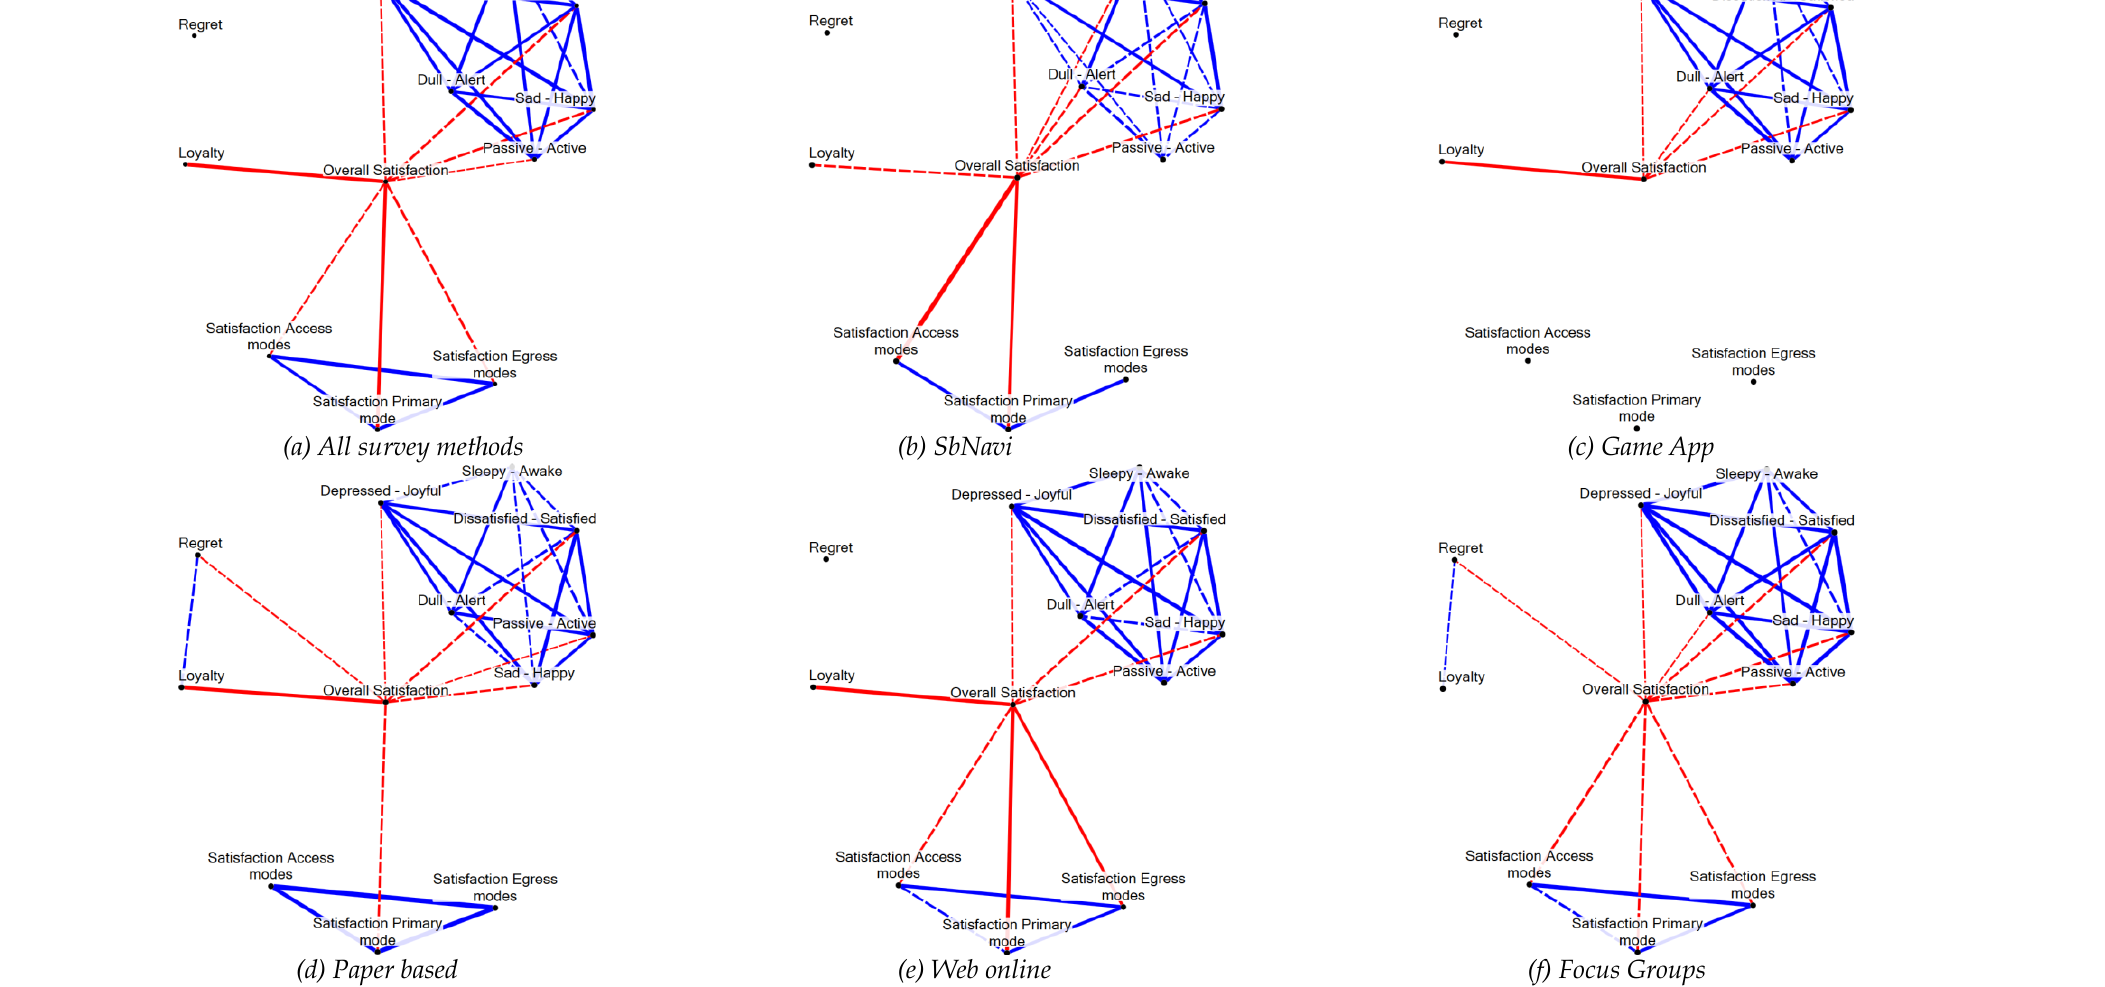
Figure 6. Relationships between overall journey satisfaction and satisfaction with various trip stages, subjective well-being spectrums, past experience and related trip appreciation factors, by different survey